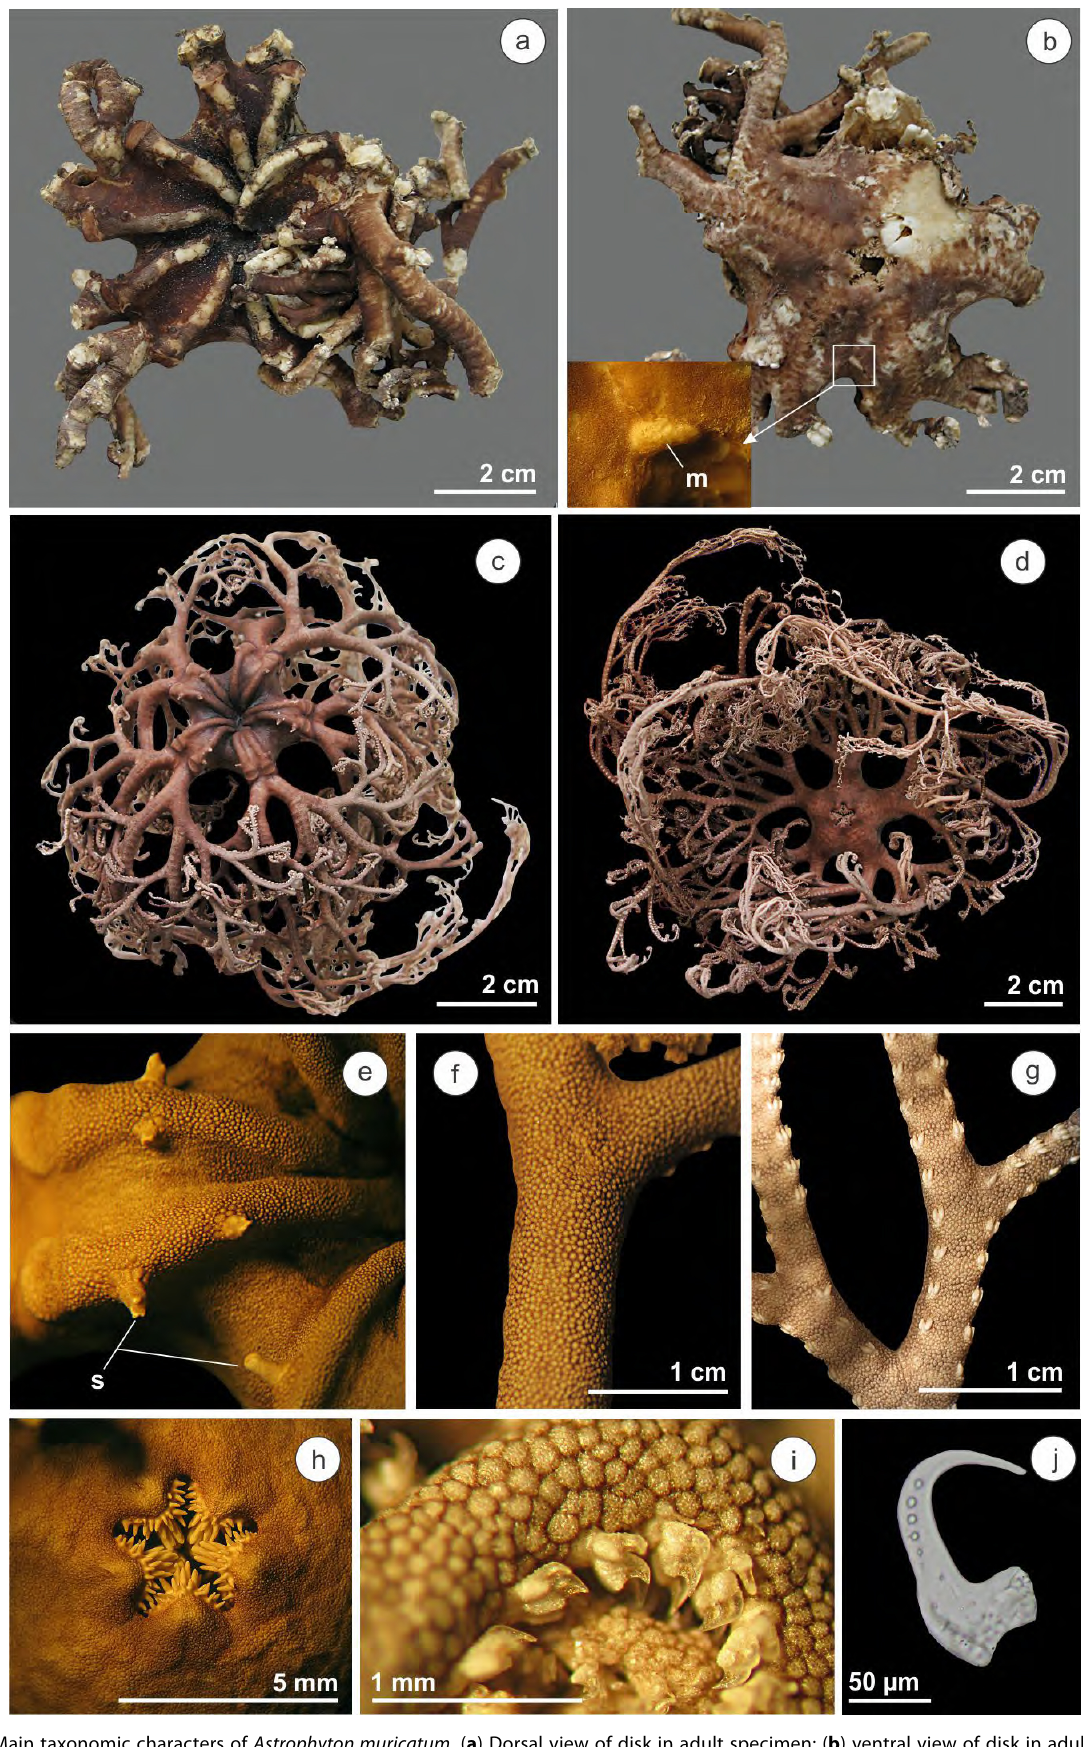
Figure 2. Main taxonomic characters of Astrophyton muricatum . ( a ) Dorsal view of disk in adult specimen; ( b ) ventral view of disk in adult specimen, madreporite in detail; ( c ) dorsal view of young specimen; ( d ) oral view of young specimen; ( e ) detail of radial shield; ( f ) dorsal view of arm; ( g ) ventral view of arm; ( h ) detail of jaw; ( i ) detail of arm spines; ( j ) microscopic hooks (optical microscopic